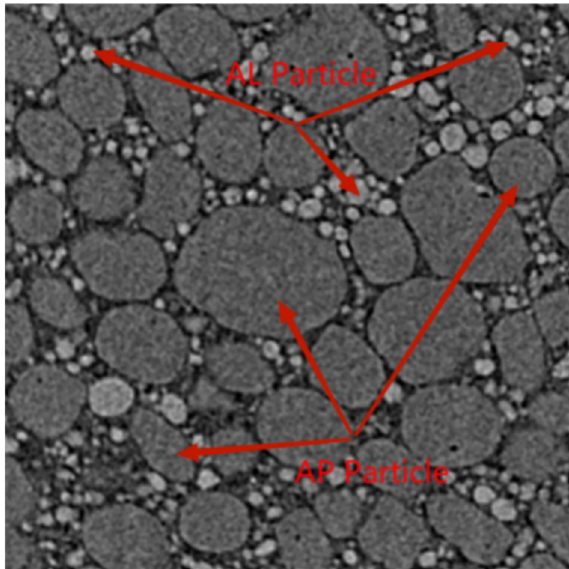
Figure 13. Real mesomorphology of HTPB